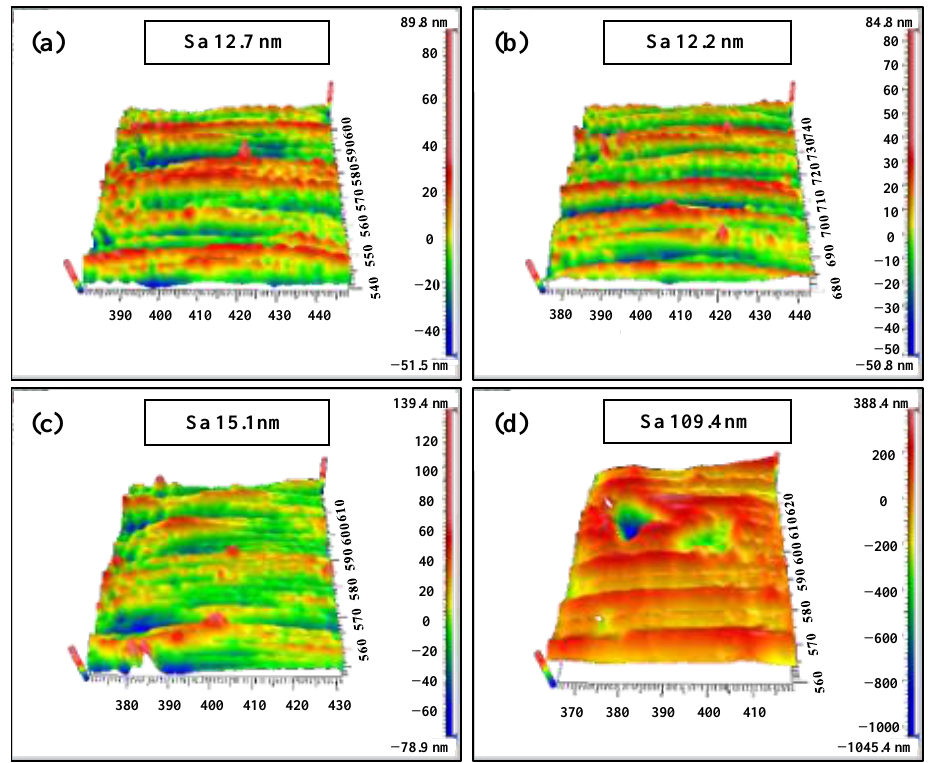
Figure 6. (Defect-free surface) Three-dimensional morphological characteristics of experimentally processed microgrooves with different feed rates per tooth: ( a ) f t = 0.27 µm/z, f t / r e = 0.15; ( b ) f t = 0.46 µm/z, f t / r e = 0.25; ( c ) f t = 1.37 µm/z, f t / r e = 0.75; ( d ) f t = 5.46 µm/z, f t / r e = 3.0.